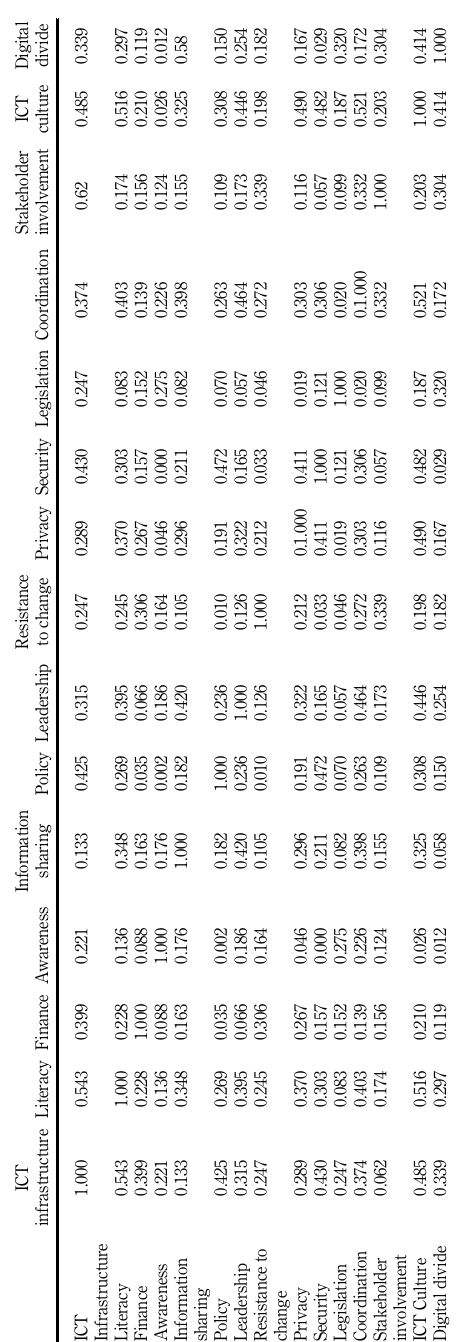
Table 3. Inter-item correlation